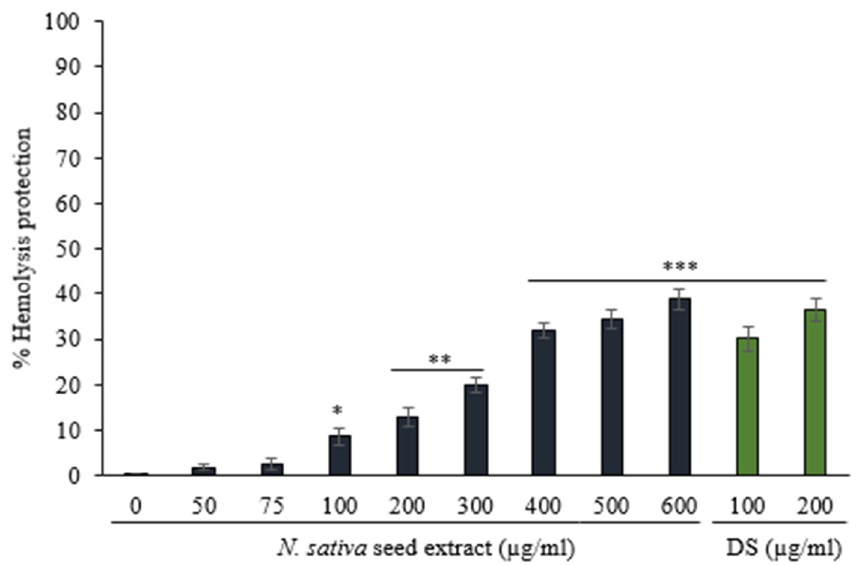
Figure 4. Effect of N. sativa seed extract on hyposaline-induced hemolysis diclofenac sodium was used as the positive control. The results are presented as means ± SEM ( n = 3. The statistical analysis was performed by using ANOVA (* p ≤ 0.05, ** p ≤ 0.01, *** p ≤ 0.001).